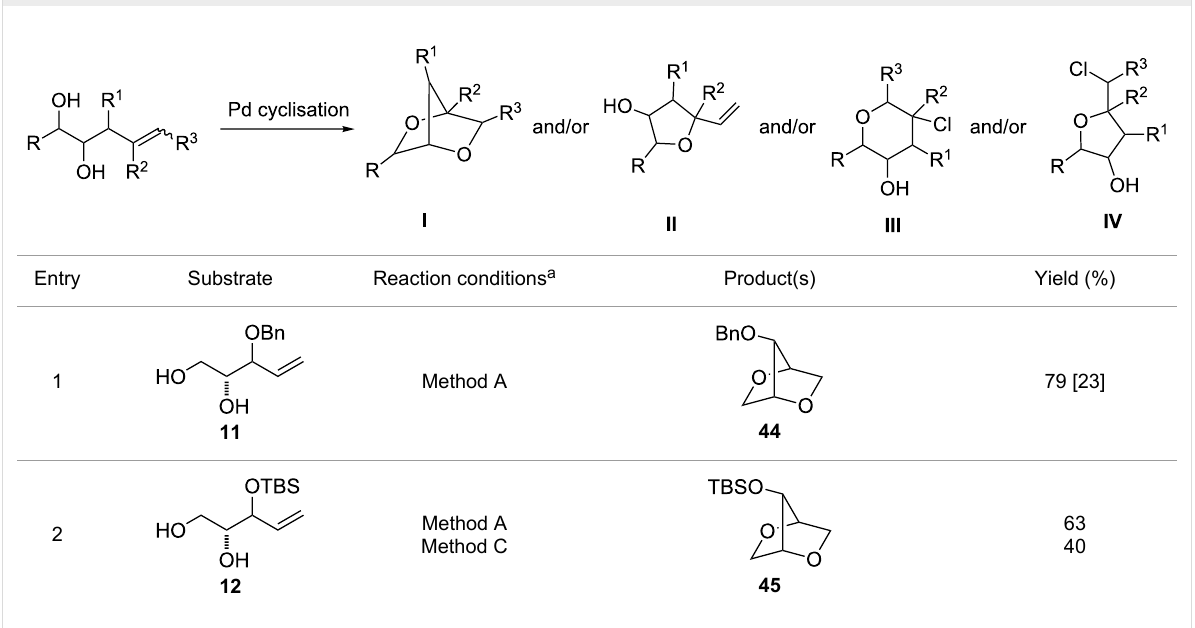
the Pd II –Pd 0 catalytic cycle (Scheme 6) were carried out using PdCl 2 (0.1 equiv) as a catalyst, CuCl 2 (3 equiv) as a reoxidant, NaOAc (3 equiv) as a buffer in AcOH at room temperature